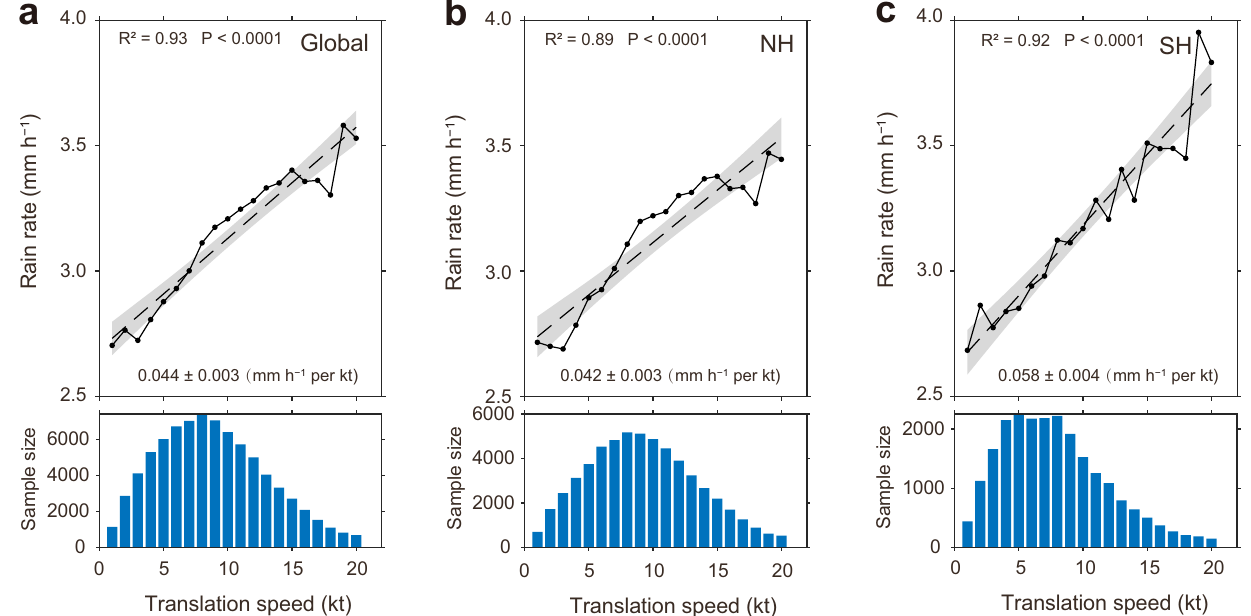
Fig. 1 | Changes in average tropical cyclone (TC) rain rate with translation speed. a Global, b Northern Hemisphere (NH), c Southern Hemisphere (SH). Only the rainy-pixels average (see Methods) is shown here. The results of the all-pixels average are shown in Supplementary Fig. 2a – c. The shaded area in all panels